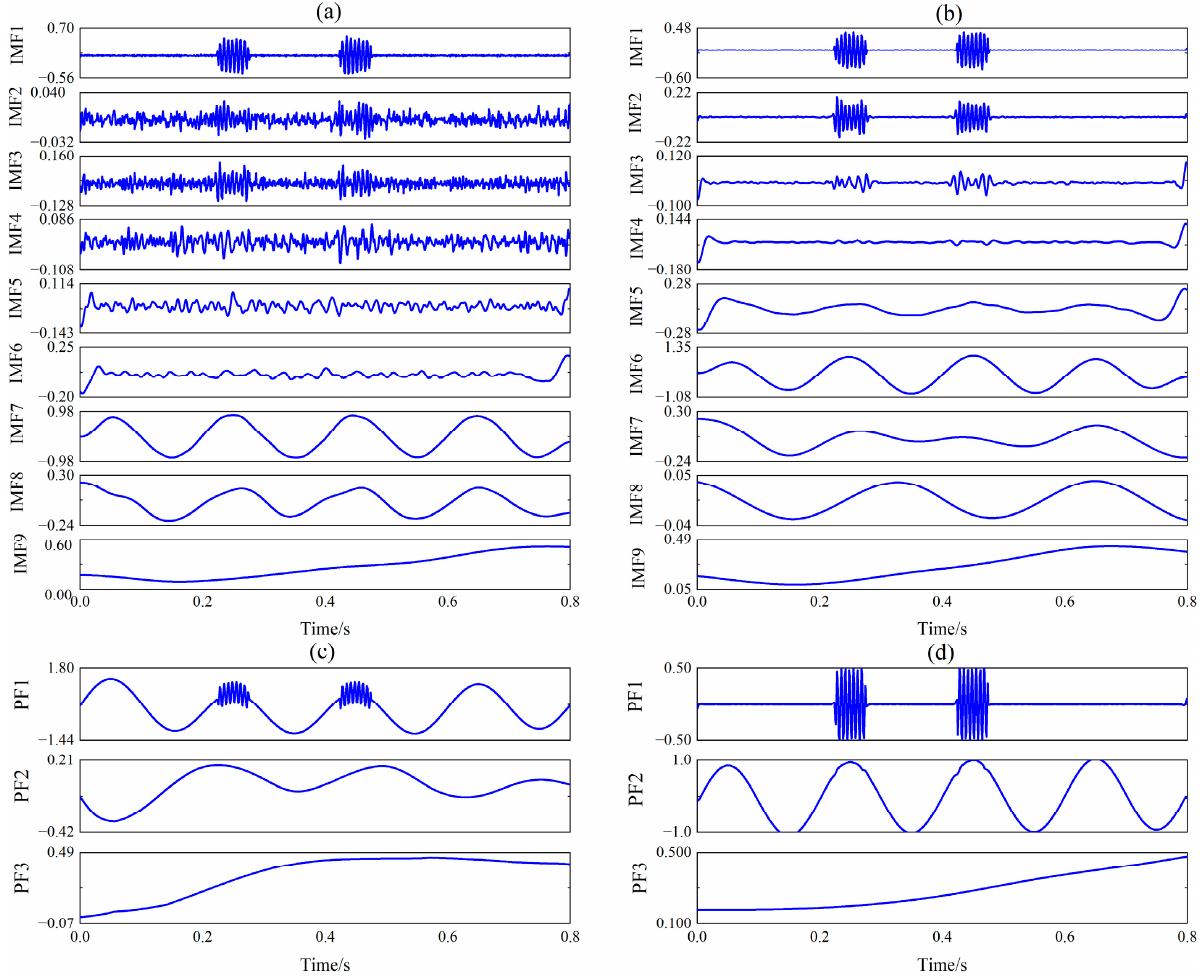
Figure 6. The results of the synthesis signal decomposed by: ( a ) CEEMDAN, ( b ) ICEEMDAN, ( c ) RLMD, and ( d ) CCERLMDAN. (Setting the same noise standard deviation parameter and ensemble number parameter in three methods).